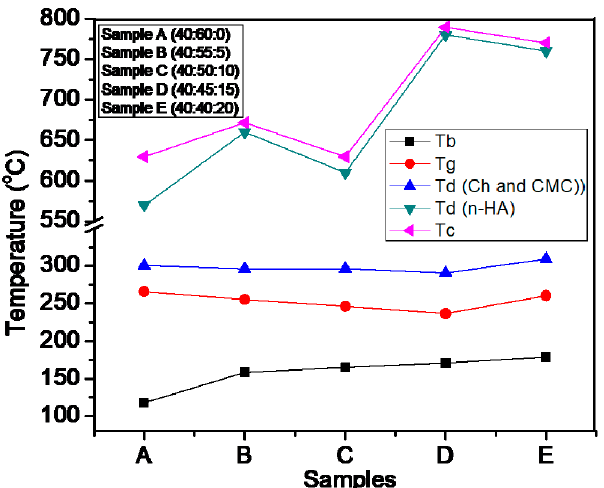
Figure 5. The variations in steam temperature ( Tb ), glass transition temperature ( Tg ), decomposition temperature ( Td ) (n-HA, Ch and CMC), and crystallization temperature ( Tc ) of the samples taken from observation of DSC measurements.